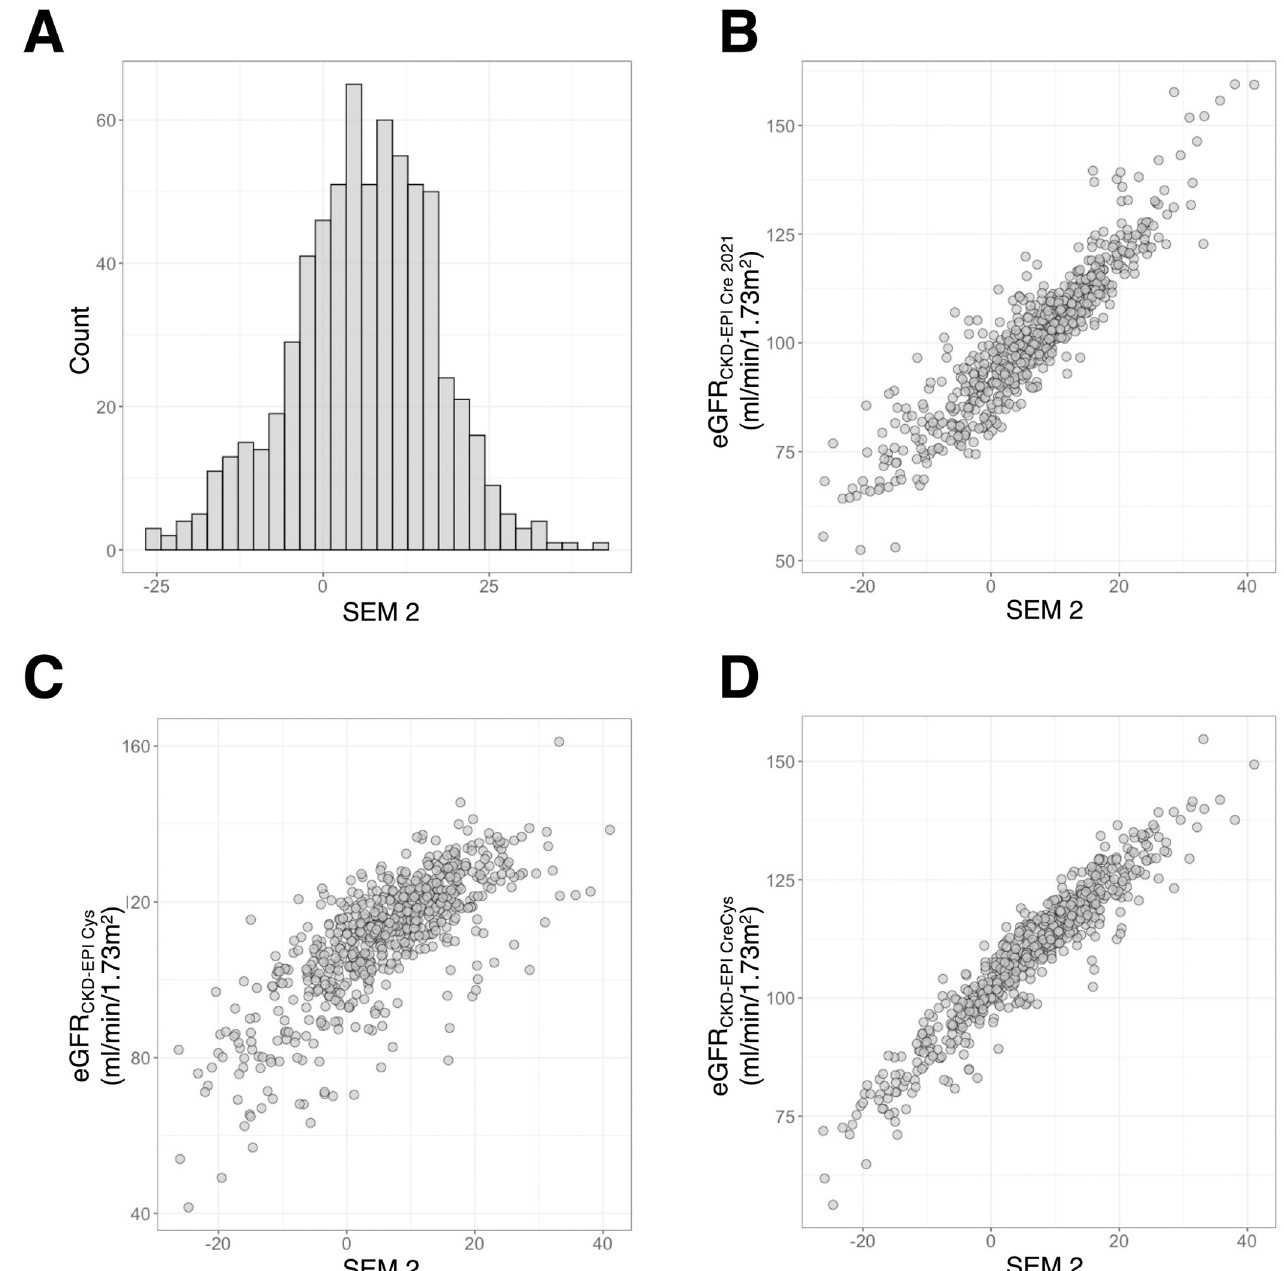
Fig 3. The distribution of latent kidney trait from model 2 (SEM 2). Panel A : Histogram of SEM 2. Panel B : Scatter plot for SEM 2 and eGFR CKD-EPI Cre 2021 . Panel C : Scatter plot for SEM 2 and eGFR CKD-EPI Cys . Panel D : Scatter plot for SEM 2 and eGFR CKD-EPI CreCys .